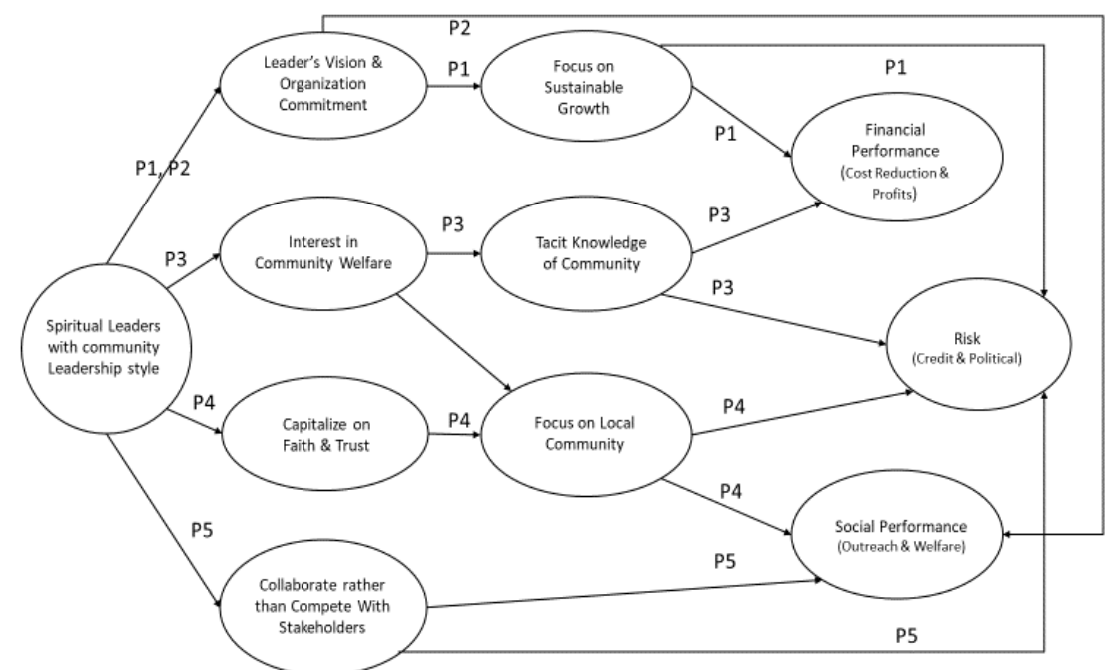
Figure 4. Conceptual framework of the impact of spiritual leaders with the Community Leadership Style.